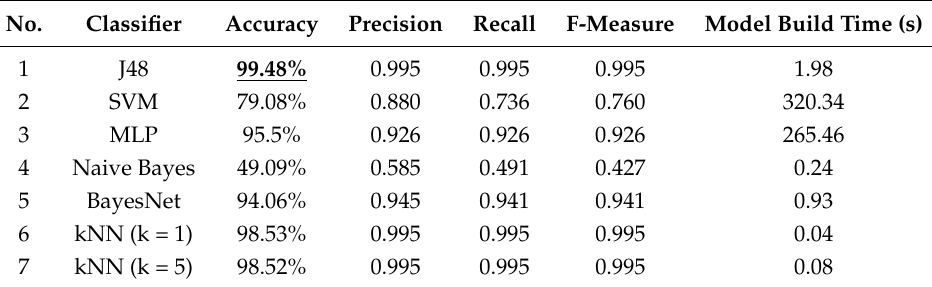
Table 7. Summary of classifiers’